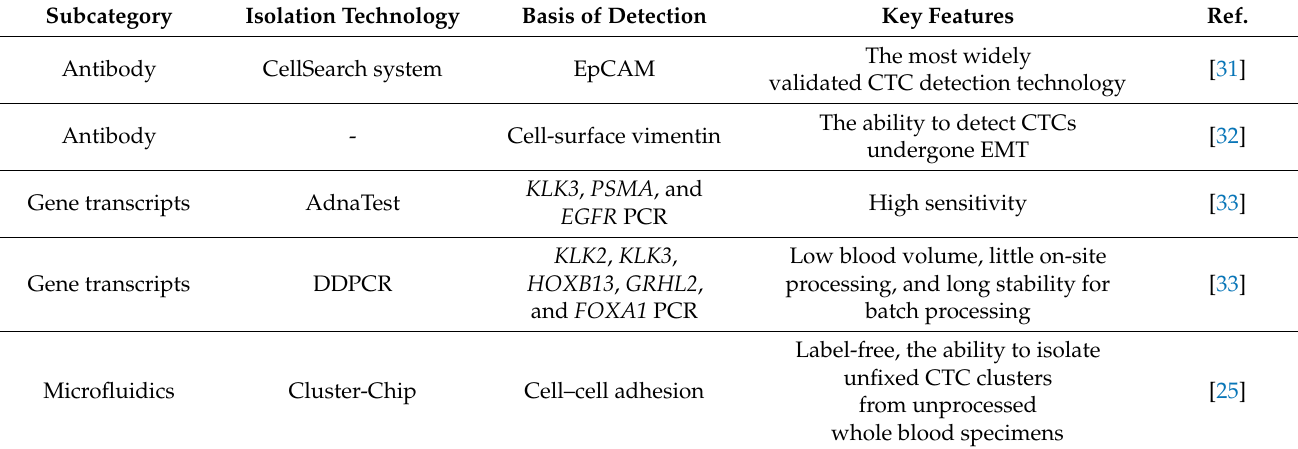
Table 1. CTC analytes and isolation devices in prostate